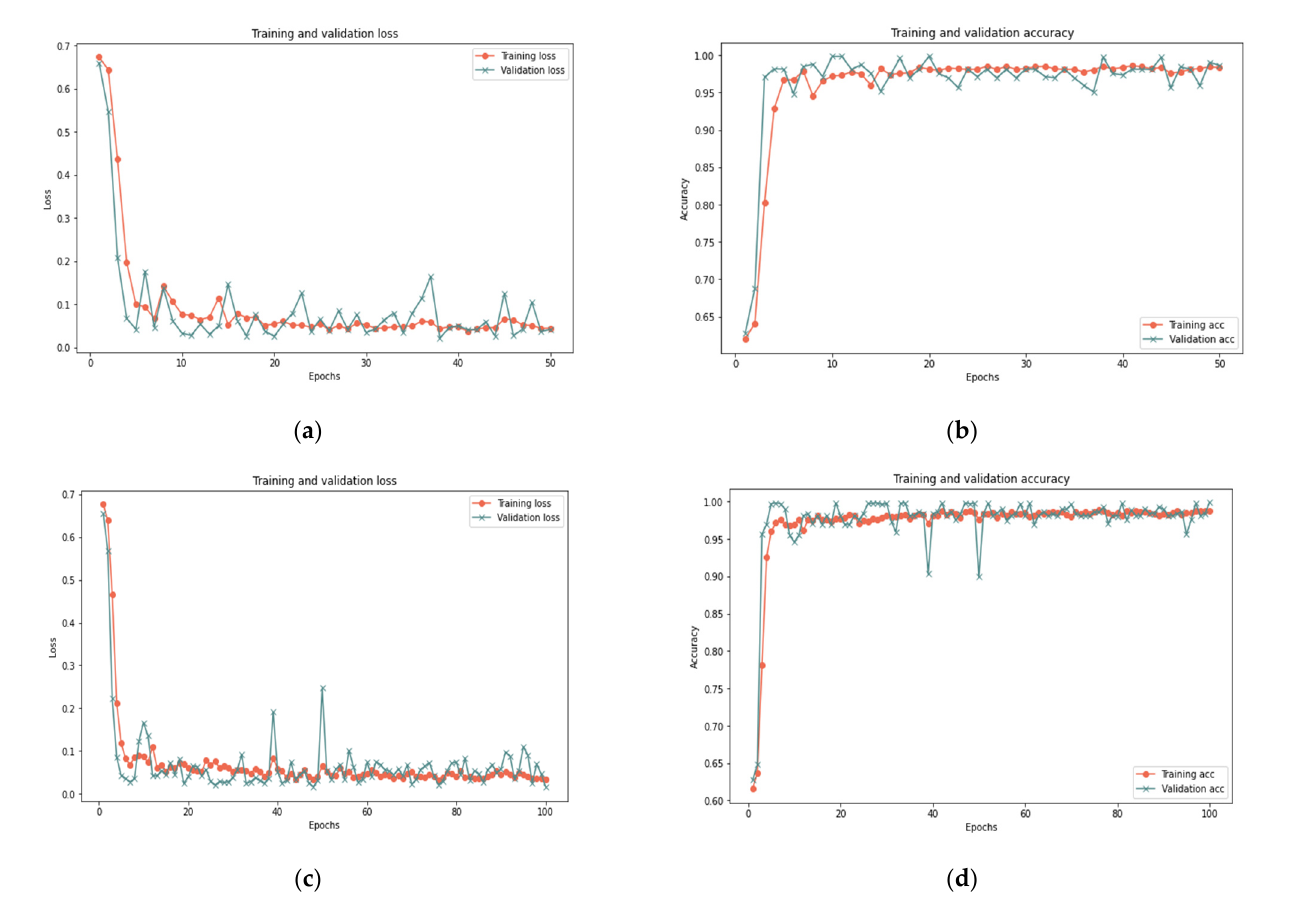
Figure 10. Results of the 50% sample size: ( a ) loss of 50 iterations, ( b ) accuracy of 50 iterations, ( c ) loss of 100 iterations, ( d ) accuracy of 100 iterations.